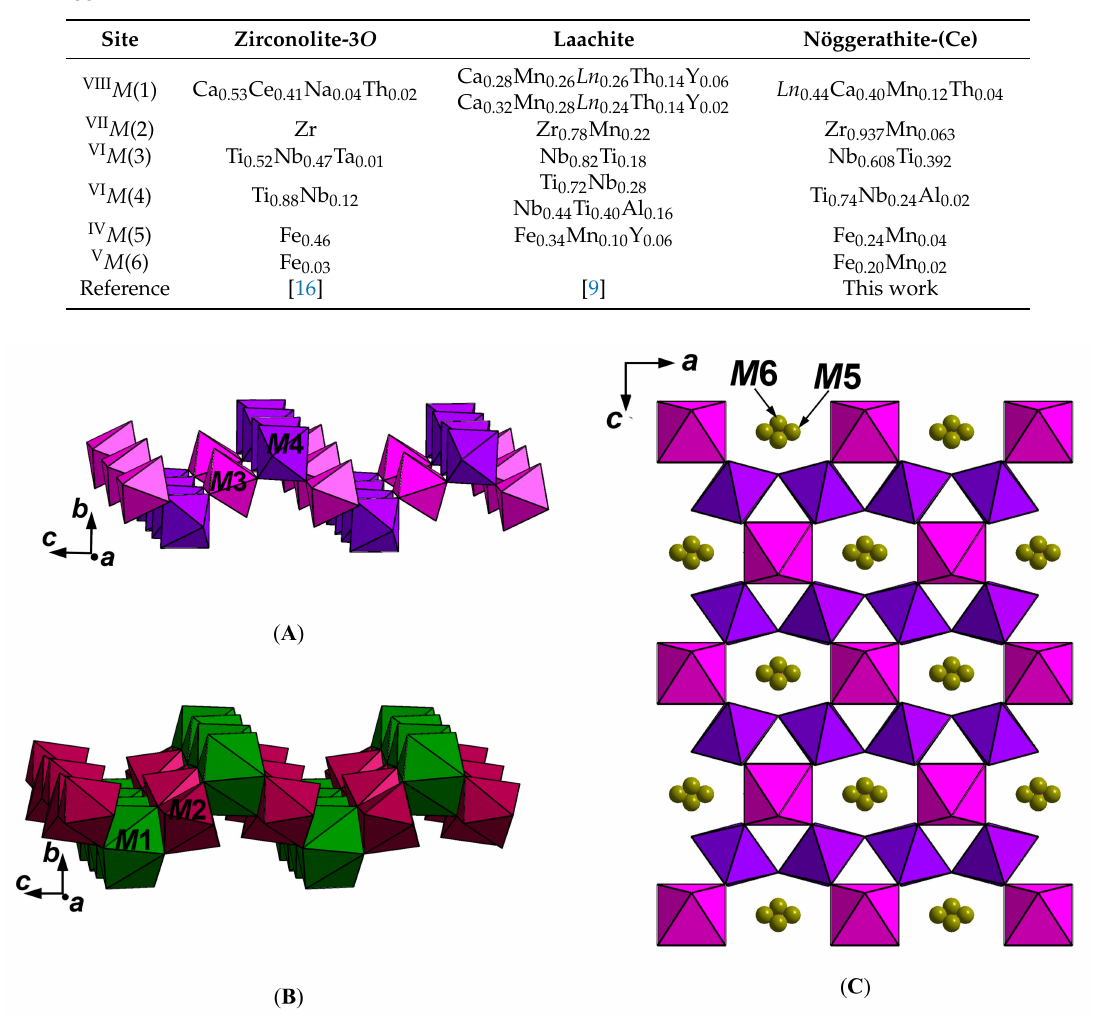
Cation distribution in structurally investigated samples of zirconolite-3 O , laachite, and nöggerathite-(Ce).